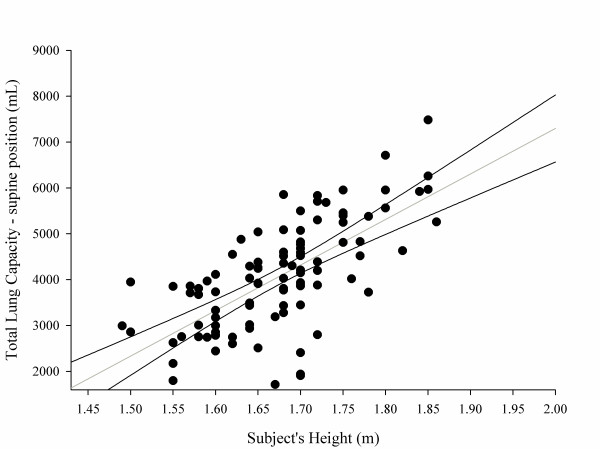
Total lung capacity in a supine position as a function of patient height (m). Total lung capacity in a supine position (ml) = -12,550 + 9,924 × subject's height (m). The 2.5 to 97.5% confidence interval for intercept = 16,227 to 8,872; 2.5 to 97.5% confidence interval for slope = 7,730 to 12,118; P <0.0001, r2 = 0.45.